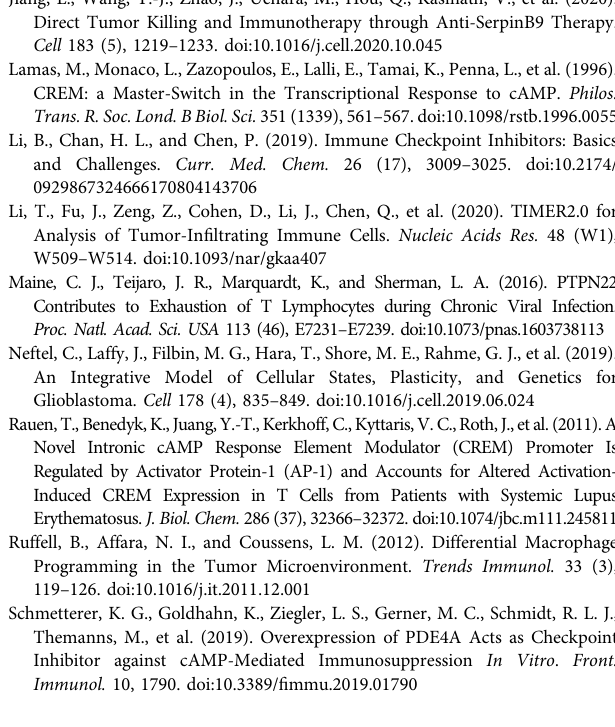
Supplementary Figure S1 | The CREM expression analysis of tumor in fi ltrating lymphocytes in glioma and non-small cell lung cancer in single cell dataset. (A) Cluster pro fi le of glioma single cell dataset in glioma GSE131928. (B) CREM expression levels of different cell types in glioma single cell dataset. (C) CREM expression levels ofdifferentTcellpopulationsinthesinglecell dataset ofnon-small cell lung cancer. (D) Cluster pro fi le of T cells in non-small cell lung cancer dataset in web database (http://lung.cancer-pku.cn). Supplementary Table S1 | Table of differential expression